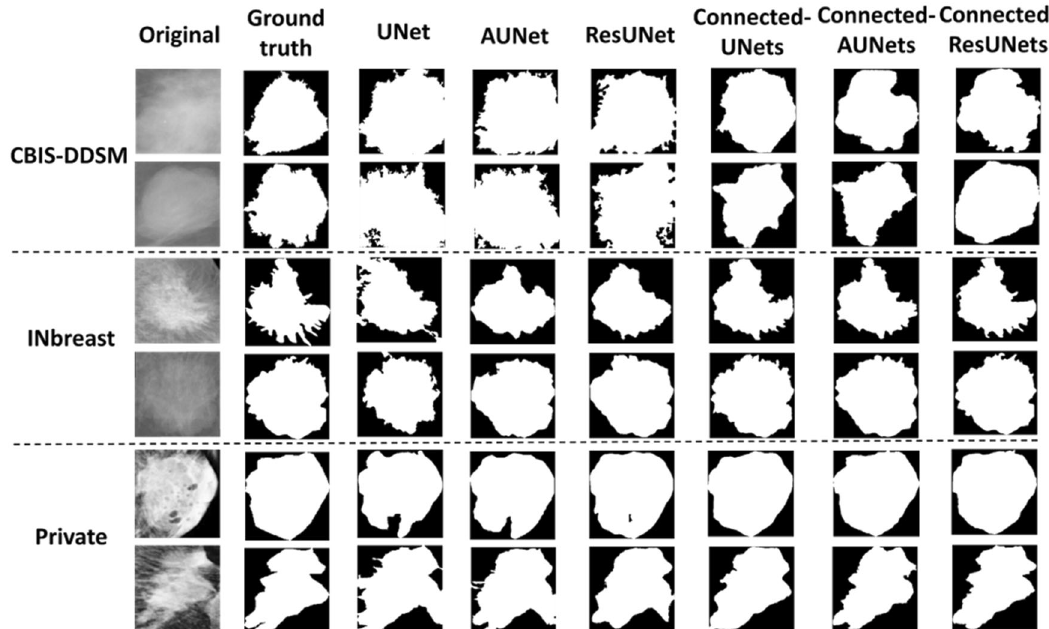
Fig. 3 Examples of the segmentation results on the test set of the datasets. Subplot on the top shows two samples of mammograms from the CBIS-DDSM dataset. Subplot on the middle shows two samples of mammograms from the INbreast dataset. Subplot on the bottom shows two samples of mammograms from the private dataset. Each sample from the two rows indicates its corresponding ground-truth (binary) image, segmentation output images of the standard models (UNet, AUNet, and ResUNet) vs segmentation output of the proposed architecture models (Connected-UNets, Connected-AUNets, and Connected ResUNets).